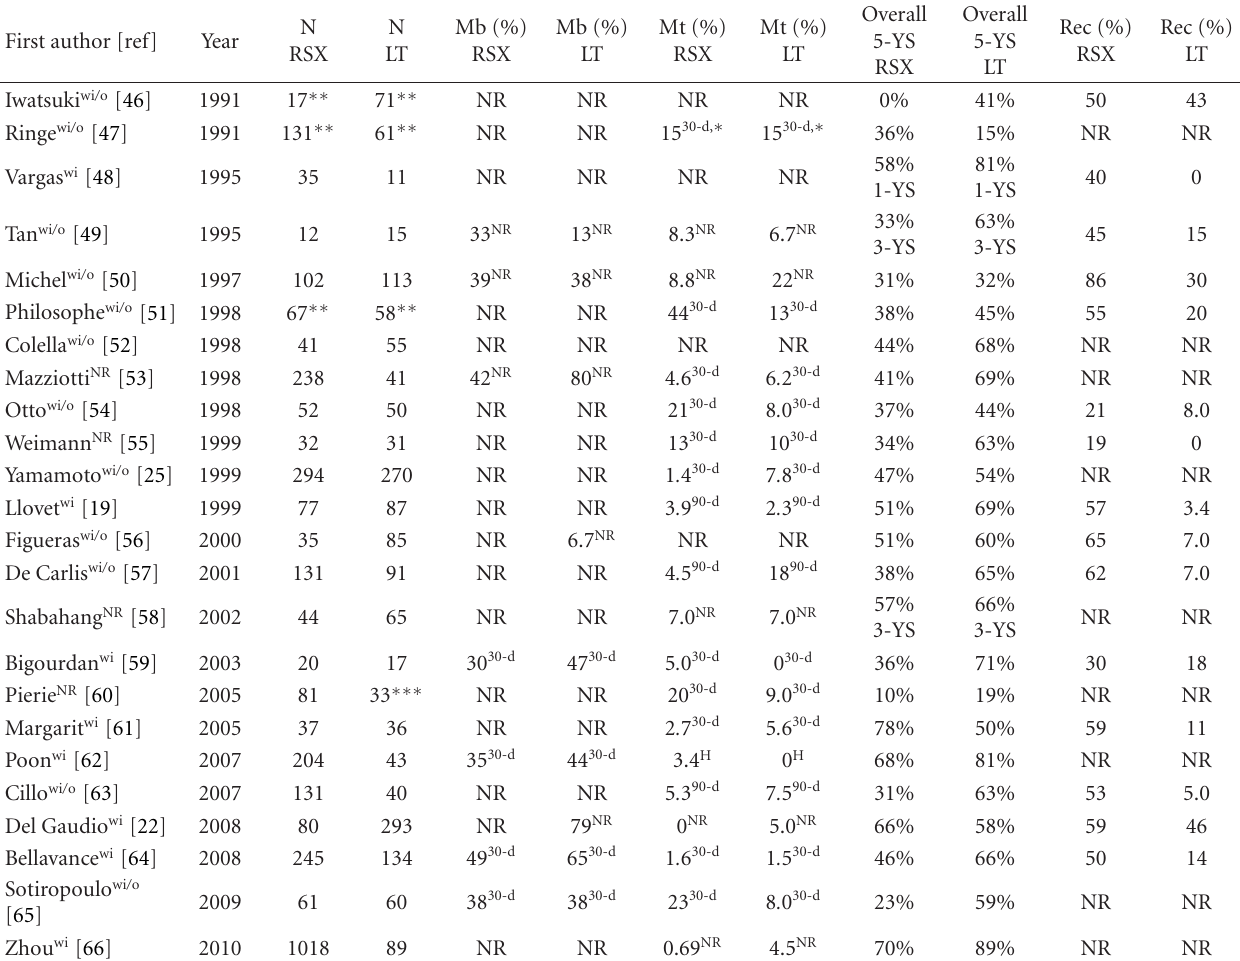
Table 1: Series comparing RSX and LT for HCC on